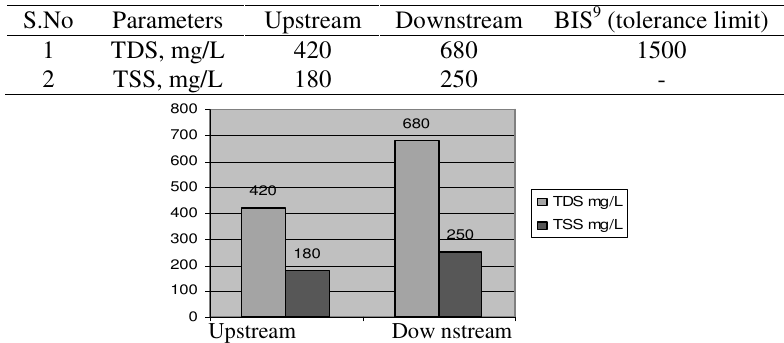
Table 2. TDS and TSS of upstream and downstream samples.